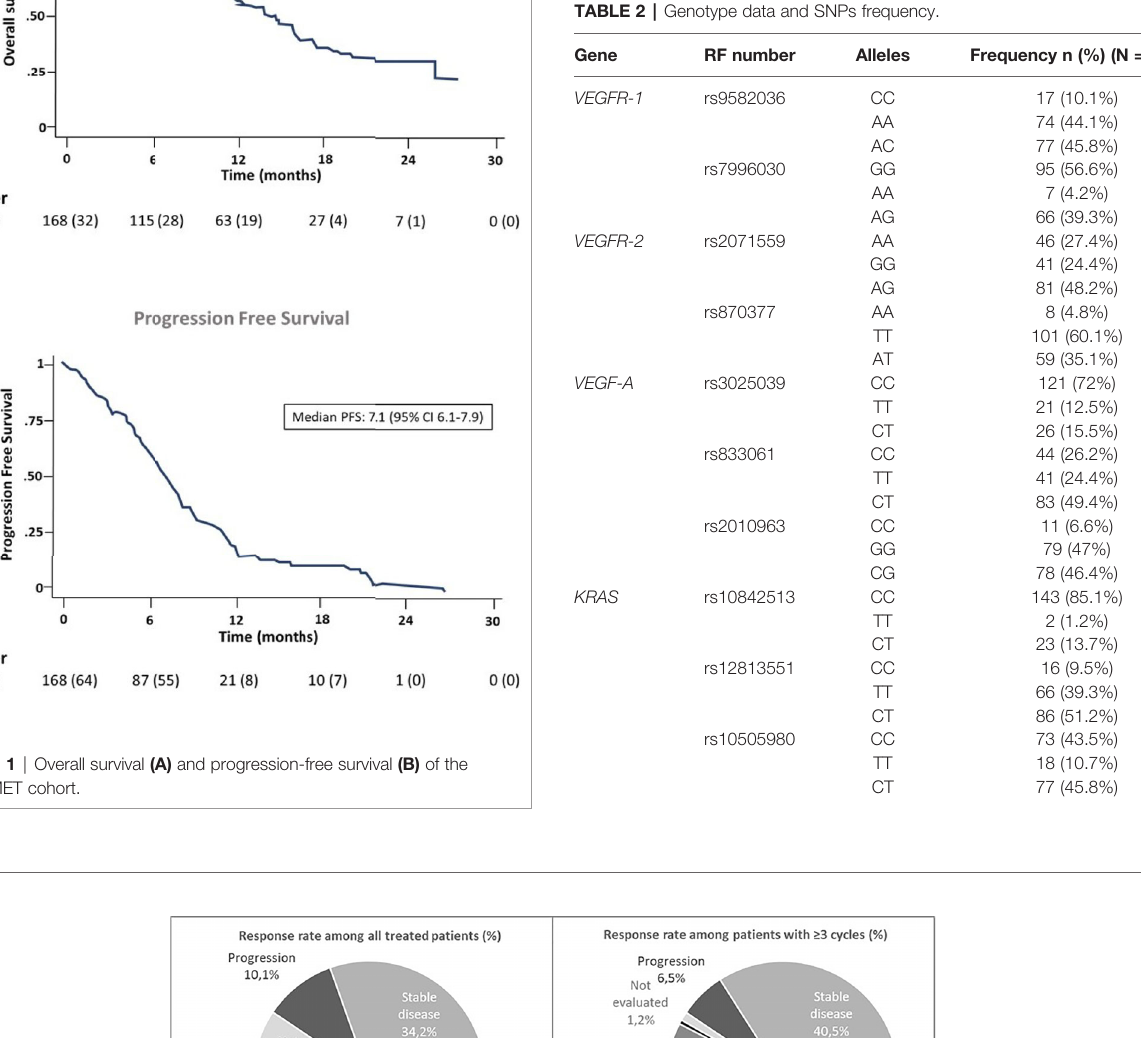
TABLE 2 | Genotype data and SNPs